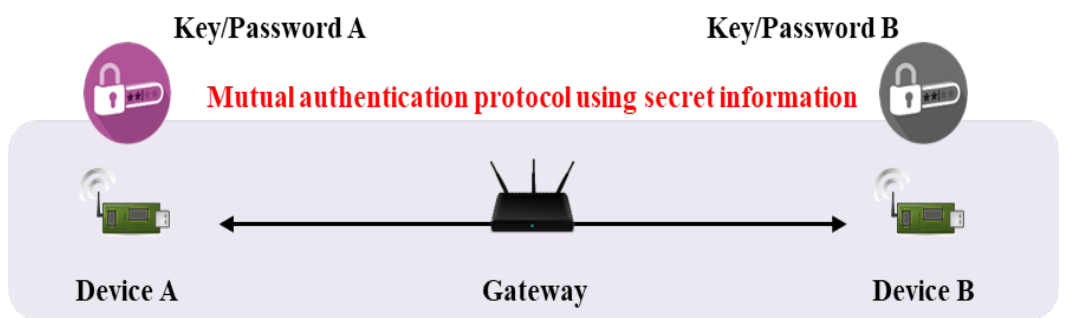
Figure 2. Mutual authentication flow with gateway.